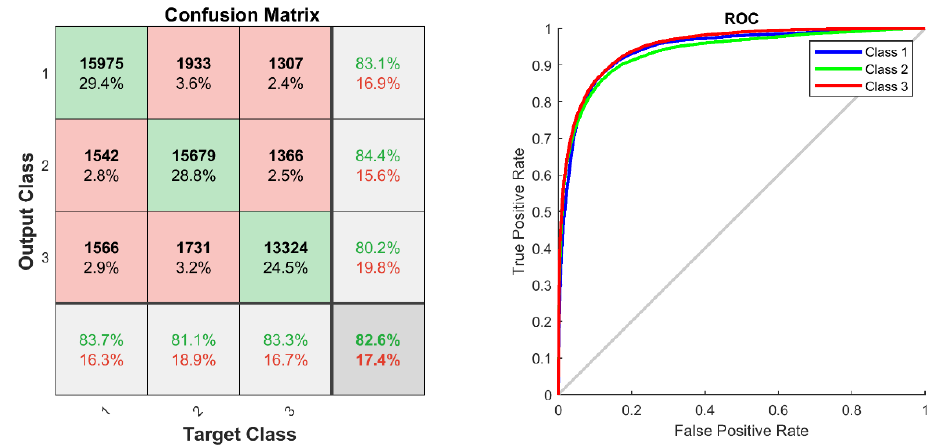
Figure 8. Confusion matrix ( left ) and ROC curve ( right ) of classifier for subject 1 on test data.